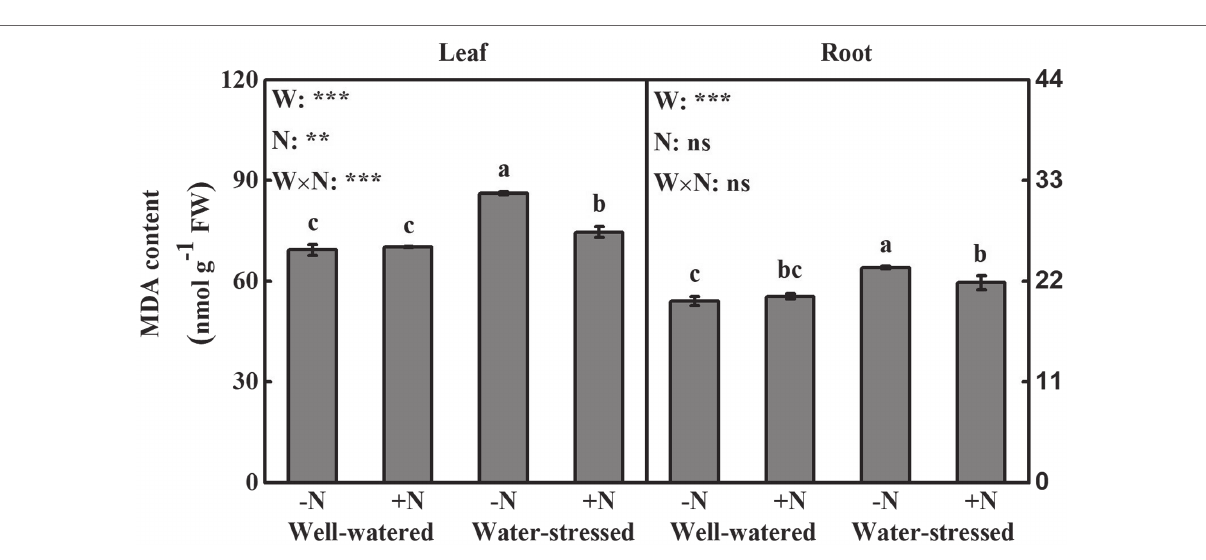
( Figure 2D ). Meanwhile, F v ′ / F m ′ , Φ PSII , and q P were also significantly lower in water-stressed plants ( Figures 2E–G ).